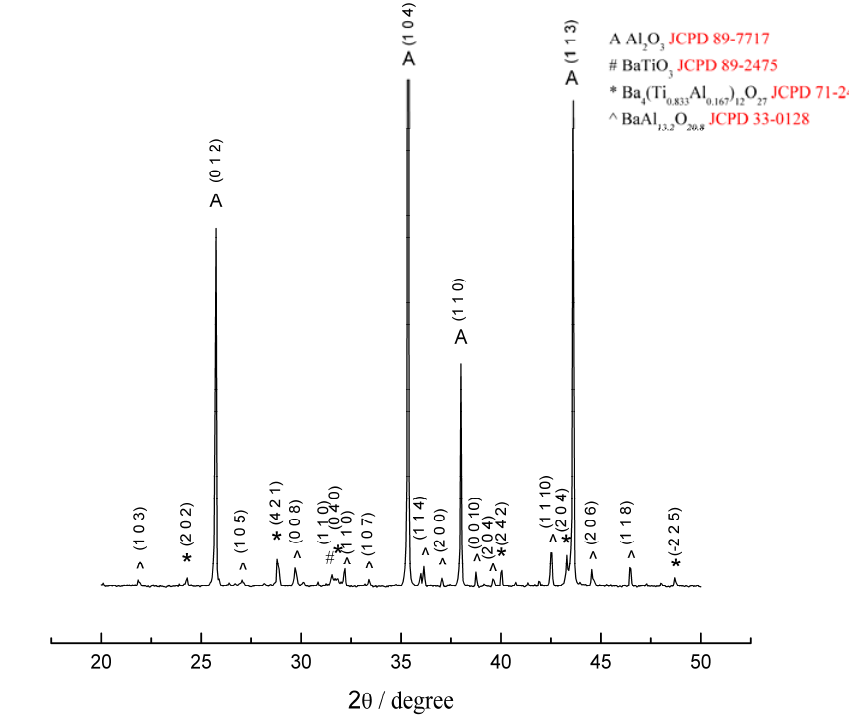
O /14wt%BaTiO 2 3